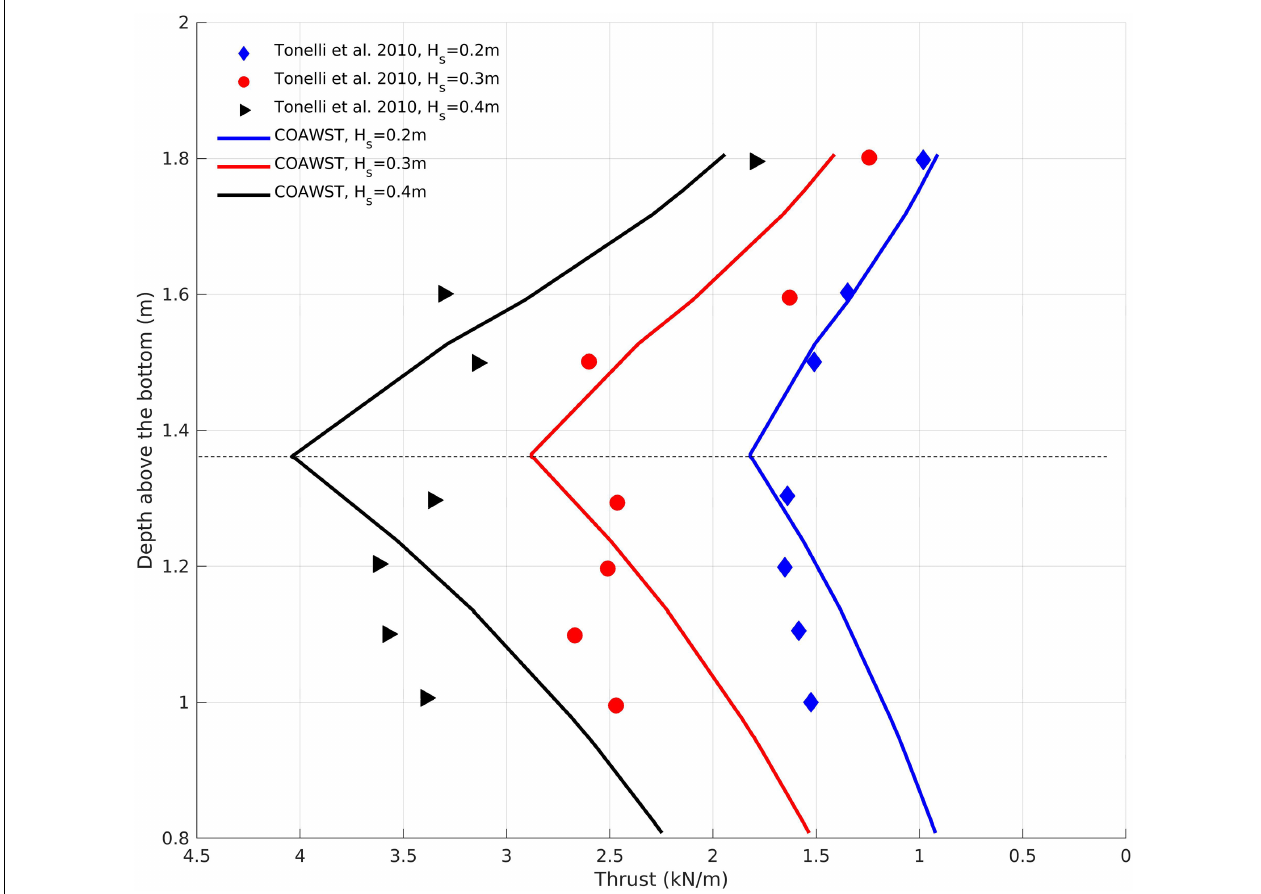
FIGURE 4 | Lateral wave thrust comparison for different incident wave heights (0.2, 0.3, and 0.4 m) between the numerical data of Tonelli et al. (2010) and COAWST model. The marsh complex is located at a depth above the bottom of 1.4 m.